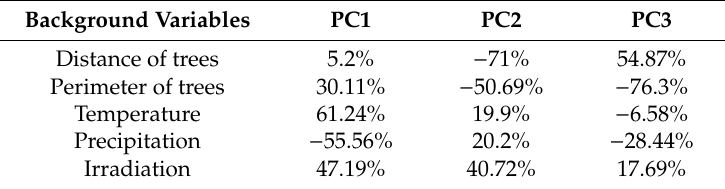
Figure 2. Visual representation of the principal component analyses (PCA) and the three groups (Group1 = Hungarian lowland regions, including the Southern Carpathian foothill (Mátra); Group2 = higher Carpathian Mountainous regions, including the Northern Carpathian foothill (Gorce); Group3 = Polish lowland regions) based on the background variables. Prec = average yearly precipitation, Ins = average yearly irradiation, Temp = average yearly temperature, TreeDist = distance of the closest trees, TreePerim = perimeter of the closest trees. Table 2. The shared percentages of the background variables on the first three PCA axes.